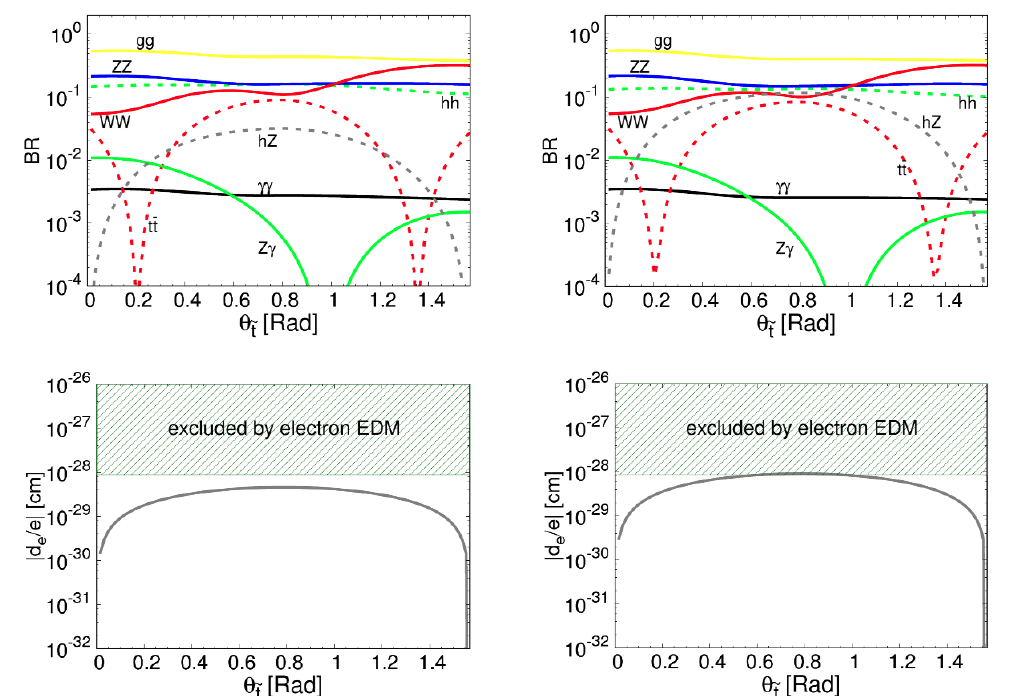
Figure 3 . Upper panels show the branching ratios of the stoponium with the corresponding predictions for the predicted eEDM from the two-loop Barr-Zee diagrams shown in the lower